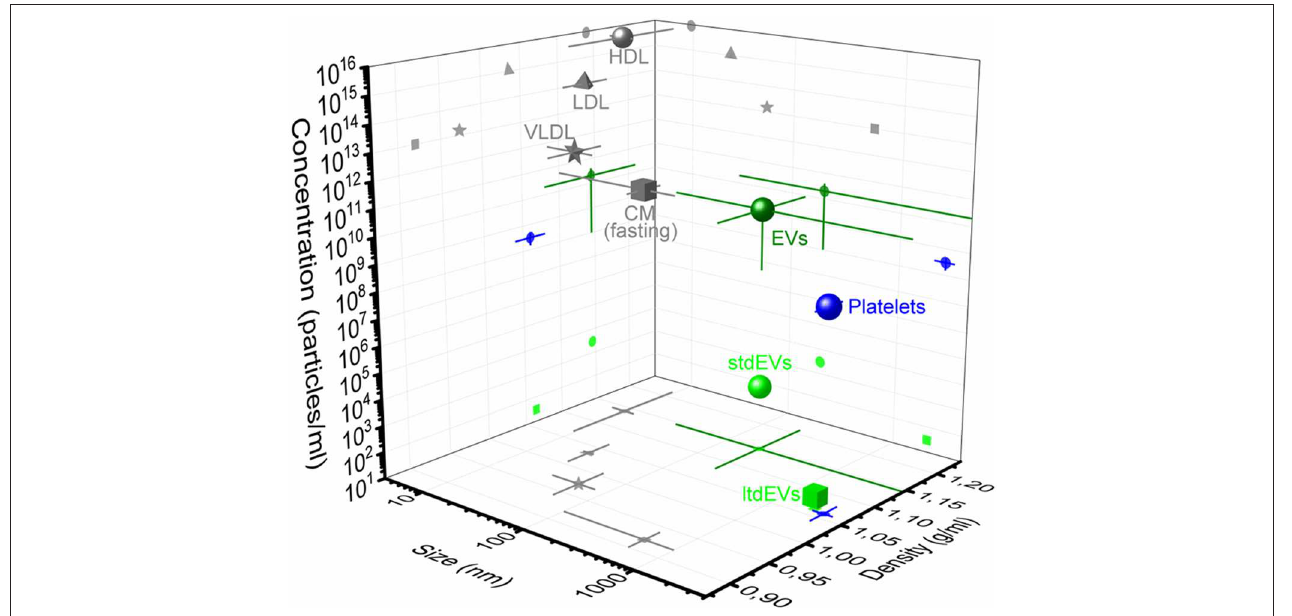
FIGURE 1 | Concentration, size, and density of plasma particles. 3D representation of concentration, size, and density of extracellular vesicles (dark green circle), platelets (blue), and the high-density lipoproteins (HDLs, gray circle), low-density lipoproteins (LDL, gray triangle), very low-density lipoproteins (VLDLs, gray star), and chylomicrons (CM, gray square) during fasting in blood. The average and standard deviation (lines) of the three parameters are indicated in the figure. Values are derived from the literature (5, 7, 11). The frequency of the large tumor-derived extracellular vesicles (ltdEVs, light green circle) determined in the Cancer-ID program and the small tdEVs (stdEVs, light green square) estimated using the frequency of ltdEVs